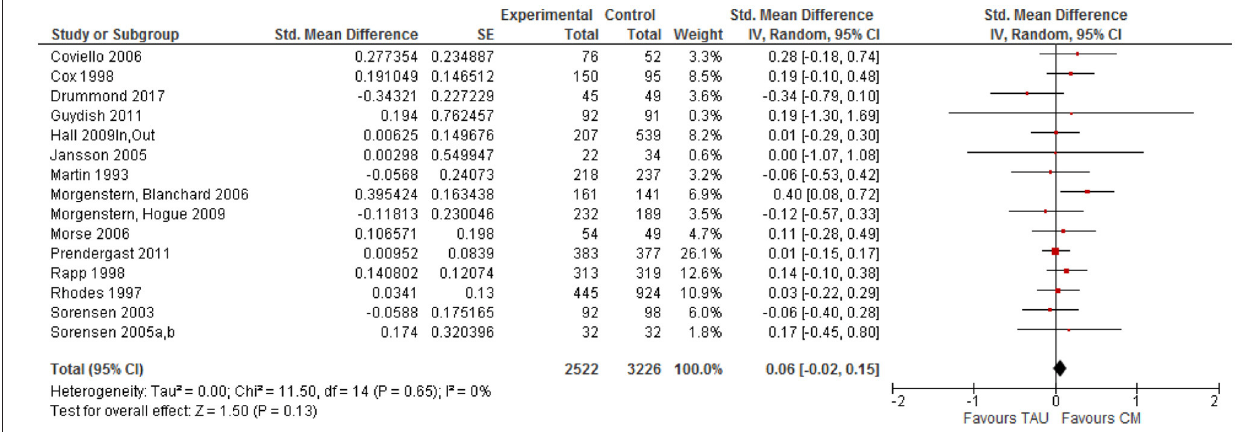
for “Random Sequence Generation,” 10 studies (4 clinical trials) were at high risk of bias, while the risk was unclear in 3